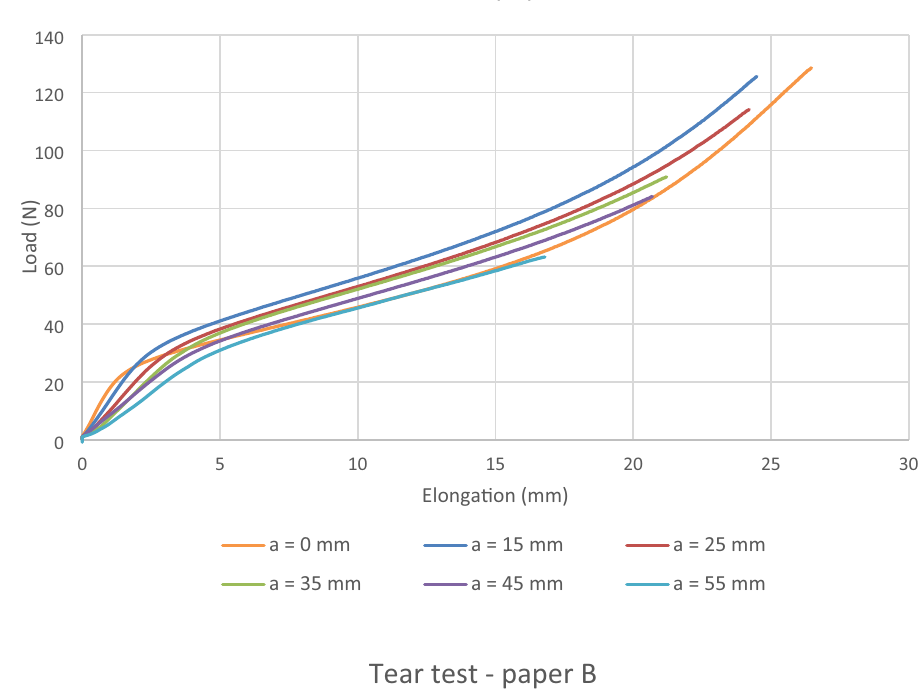
Fig. 10 Tear test curves of paper A per misalignment